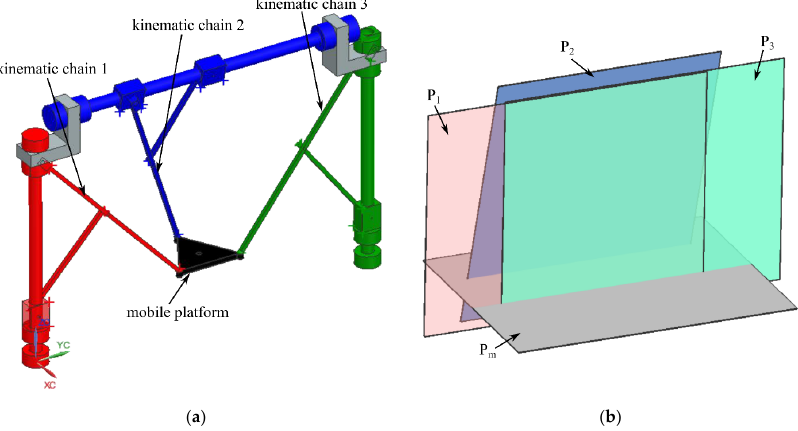
Figure 9. Type II singularity of the 6-DOF parallel robot for SILS (Case 4 — two faces of the charac- teristic tetrahedron are coplanar): ( a ) parallel robot pose; ( b ) characteristic planes.